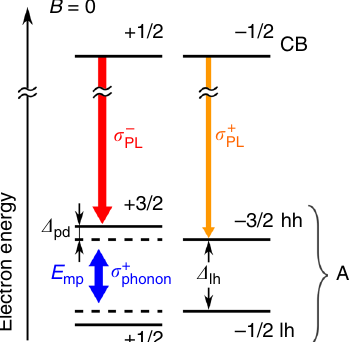
Fig. 5 Energy scheme of the spin states. The acceptor states (A 0 ) with spin projections + 3/2 and + 1/2 are shifted with respect to the unperturbed energy states due to the phononic ac Stark effect mediated through the elliptically polarized phonons which are emitted by the magnetized FM with preferential σ + polarization. The unperturbed + 3/2 and + 1/2 energy states are indicated by the dashed lines. Conduction band (CB) states have spin projections ±1/2 the magnon – phonon resonance energy). Analogously to the optical ac Stark effect, the constant Δ pd is determined by the detuning Δ lh ( E ) − E mp of the phonon energy E mp (analog of the photon energy ħ ω ) from the splitting Δ lh ( E ) (analog of the energy of the optical transition in an atom). The sign of P c the vicinity of the magnon – phonon resonance depends on the sign of the projection of the magnetization component of the interfacial ferromagnet onto the z -axis. The electric fi eld E across the QW increases Δ lh ( E ) due to the static quadratic Stark effect. For small values of the electric fi eld directed along the z k½ 001 (cid:4) axis